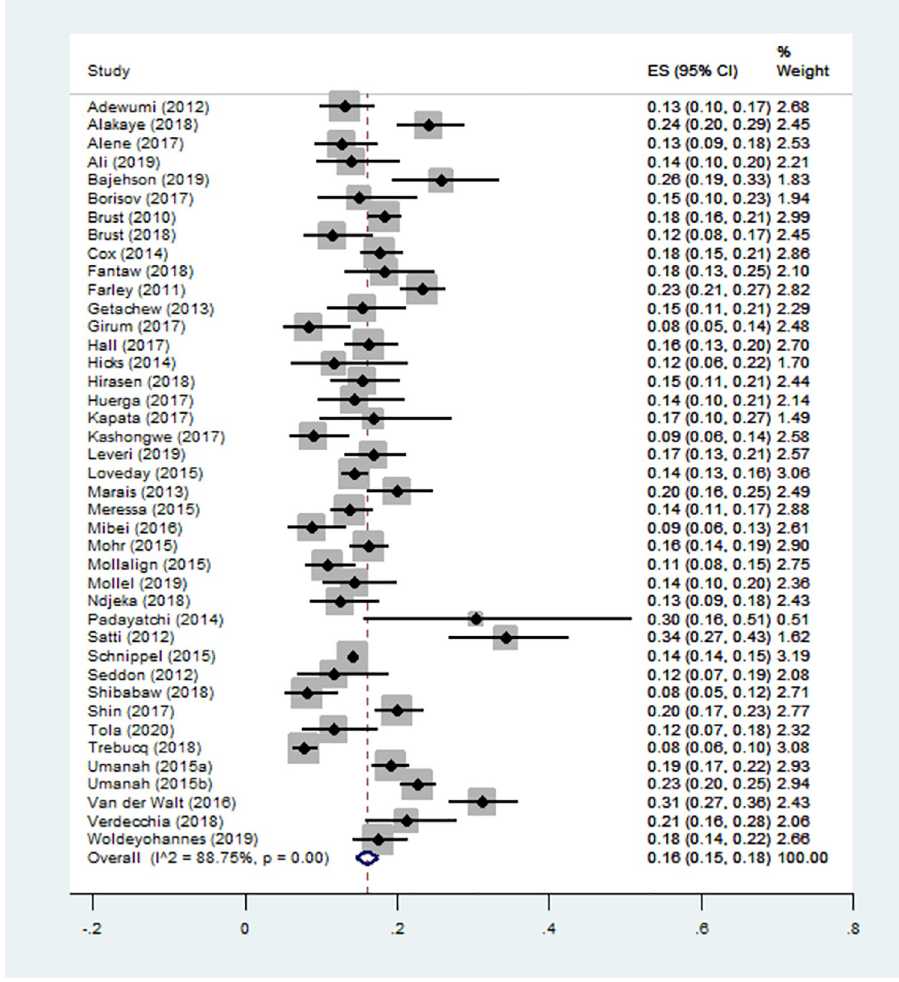
Fig 3. Forest plot for incidence proportion of mortality by excluding